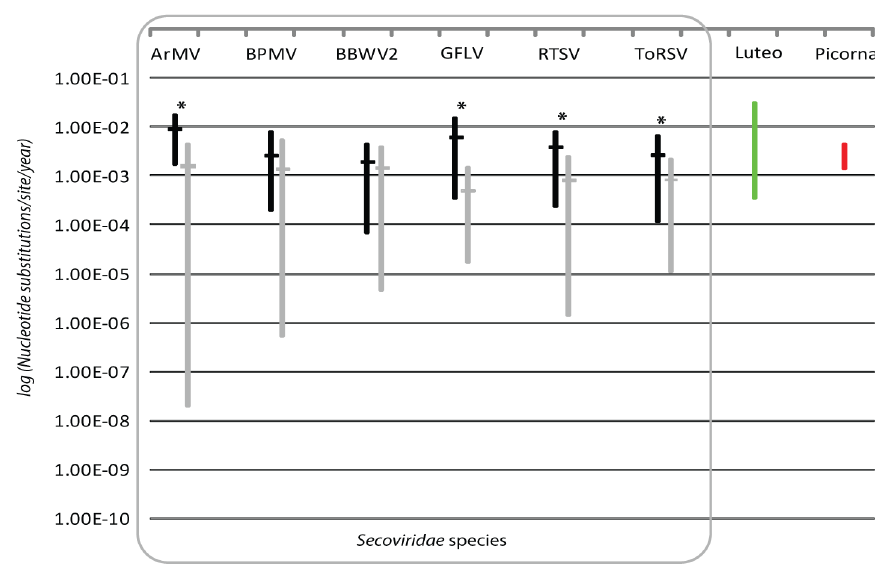
Figure 2. Estimates of the nucleotide substitution rates per site for the coat proteins of nine secovirids. Arabis mosaic virus (ArMV), Bean pod mottle virus (BPMV), Broad bean wilt virus-2 (BBWV-2), Blackcurrant reversion virus (BRV), Grapevine fanleaf virus (GFLV), Rice tungro spherical virus (RTSV), Strawberry mottle virus (SMoV), Tomato ringspot virus (ToRSV) and Tobacco ringspot virus (TRSV). Real (time-tipped) mean values (black horizontal bars) are aligned with randomized (gray horizontal line) with the 95% highest posterior density (HPD) ranges for each depicted by the vertical bars. * - estimates considered statistically solid based on mean values being outside the range of the randomized HPD. Substitution rates for data spreading less than 10 years (BRV and SMoV) or where the HPD ranges was larger in the randomized than in the time-tipped calculations (TRSV) (See Table 3) are not depicted. On the right are depicted the mean substitution rate distributions for coat proteins of the Luteoviridae (green bar) (Pagan and Holmes 2011), and the VP1 of Picornaviridae (Hicks and Duffy, 2011).